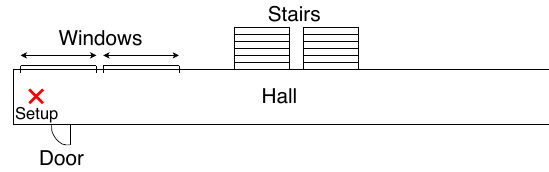
Figure 5. Hall Scenario: A mixed indoor/outdoor environment at auditorium hall.